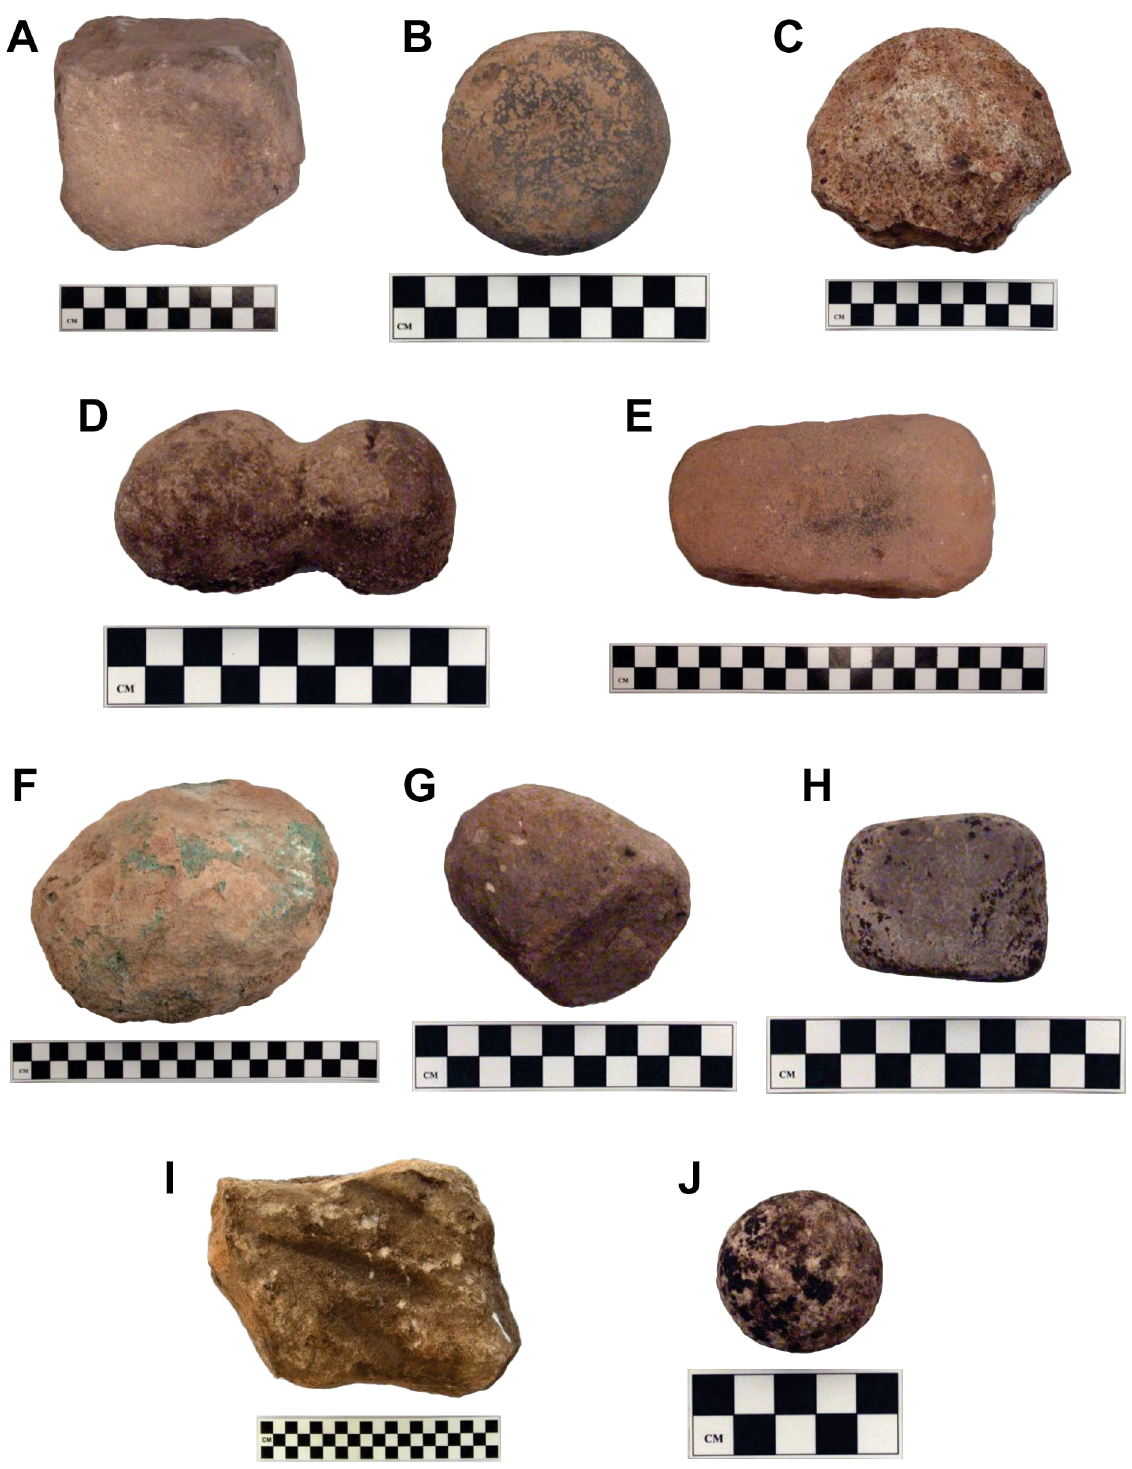
Figure 11. Selected handstones from Khirbat en-Nahas, 2006 excavations. A, dimpled hammerstone, Area A, Locus 183; B, dimpled hammerstone, Area M, Locus 672; C, hammerstone, Area M, Locus 721; D, grooved hammerstone, Area T, Locus 1541; E, grinding handstone, Area A, Locus 183; F, pounder, Area T, Locus 1517; G, pestle, Area M, Locus 701; H, polishing stone, Area M, Locus 707; I, sharpening stone, Area M, Locus 685; J, ballistic stone, Area R, Locus 1827. Individual squares in the scale bars are 1 cm